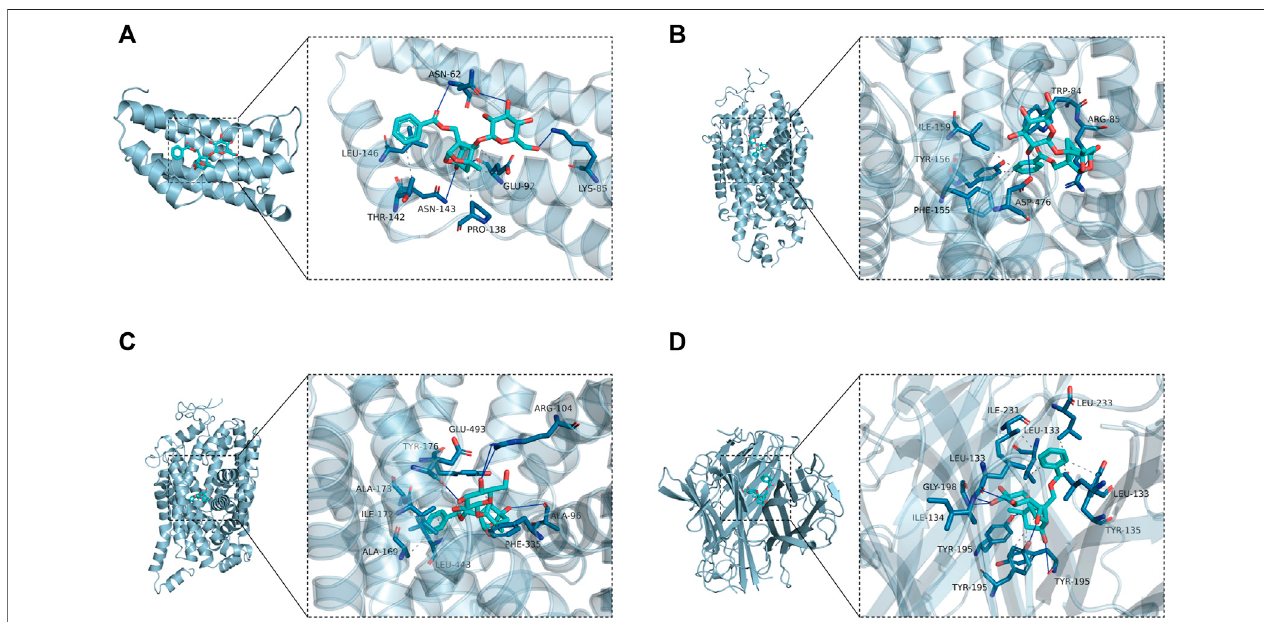
FIGURE 8 | Molecular docking-predicted binding mode. (A) Molecule docking of PF binding to IL6 . (B) Molecule docking of PF binding to SLC6A3 . (C) Molecule docking of PF binding to SLC6A4 . (D) Molecule docking of PF binding to TNF . Left panel, overall view; right panel, partial view; cyan stick, small molecule; light blue cartoon, protein; blue line, hydrogen bond; gray dotted line, hydrophobic